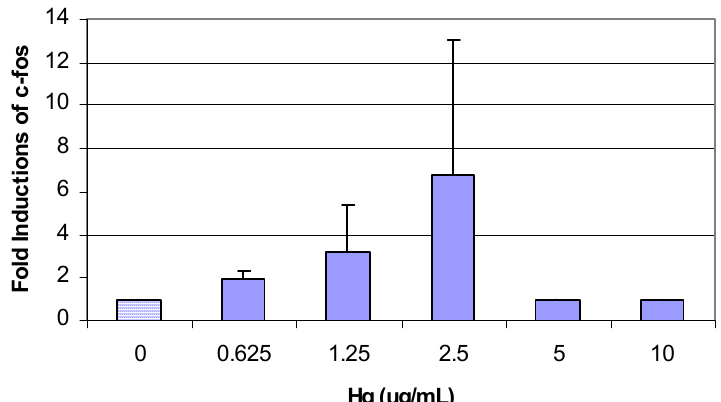
Figure 7. Fold induction of c-fos in HepG means ± SDs, n = 3.